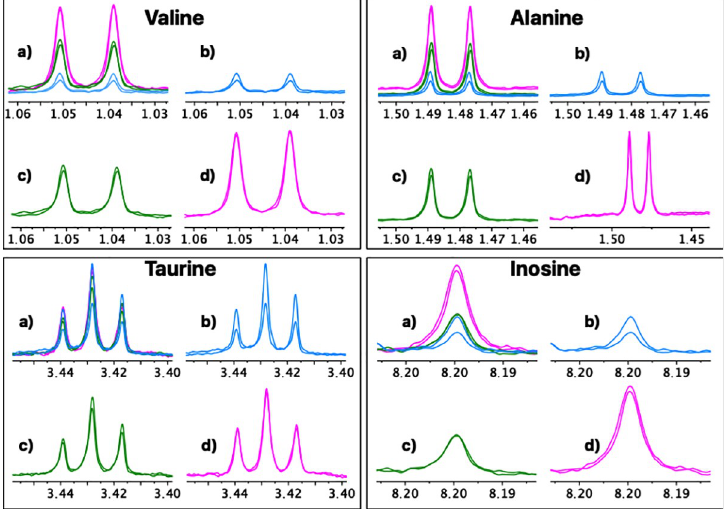
Fig 5. Comparative repeatability graphical analysis (FM vs. UM vs. UUM) for metabolites Valine, Alanine, Taurine and Inosine. a) Three overlapping methods, b) Folch method, c) Ultrasound and ultrafiltration method, d) Ultrasound method. A duplicate spectrum, acquired for the same patient and on the same day, is shown for each method.